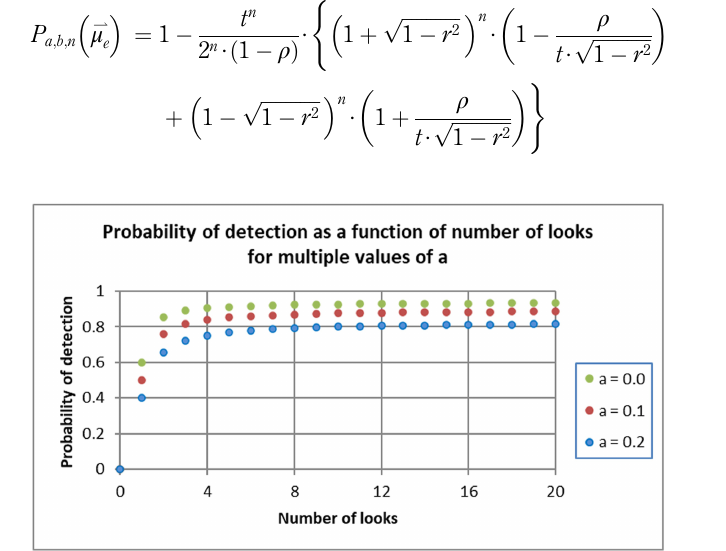
Figure 17. Probabilityofdetection asafunctionofnumber of looks